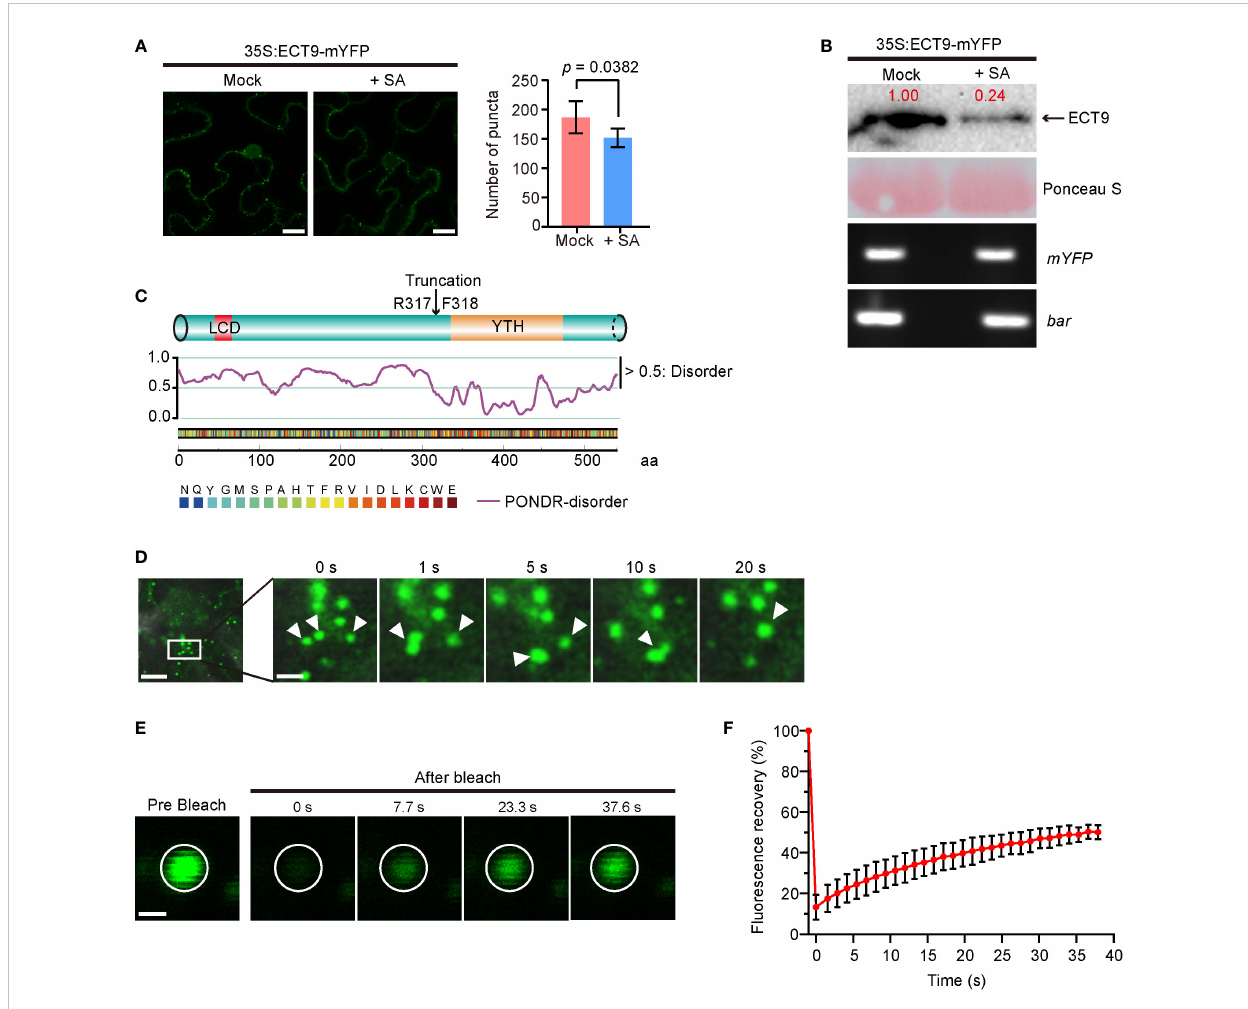
FIGURE 1 ECT9 exhibits liquid-liquid phase separation (LLPS) behavior in vivo and responds to salicylic acid (SA). (A) Number of puncta in N. benthamiana leaves expressing 35S:ECT9-mYFP after 3-hour treatment with 2 mM SA. Mean ± SD (n = 5). Mock, H 2 O. Scale bar, 10 µm. p value by Two-sided Student ’ s t -test. (B) Protein and mRNA expression levels of ECT9 in (A) . Relative value of protein was marked by Image Lab. Ponceau S, protein loading control. bar , the selection marker gene basta on the 35S:ECT9-mYFP binary T-DNA vector. (C) Disordered region prediction of ECT9. Top, schematic diagram of protein domains of ECT9 from UniProt. Bottom, disordered score predicted by ‘ Predictor of Natural Disordered Regions ’ (PONDR; http://www.pondr.com/). Scores above 0.5 indicate disordered regions. (D) Fluorescence time-lapse microscopy of N. benthamiana leaves expressing 35S:ECT9-mYFP . Three fusing bodies are zoomed in. Scale bar, 10 µm (left) and 2.5 µm (right). (E) FRAP of ECT9-mYFP condensates. Time 0 indicates the start of the photobleaching pulse. Scale bar, 2 µm. (F) A plot showing the time course of the fl uorescence recovery